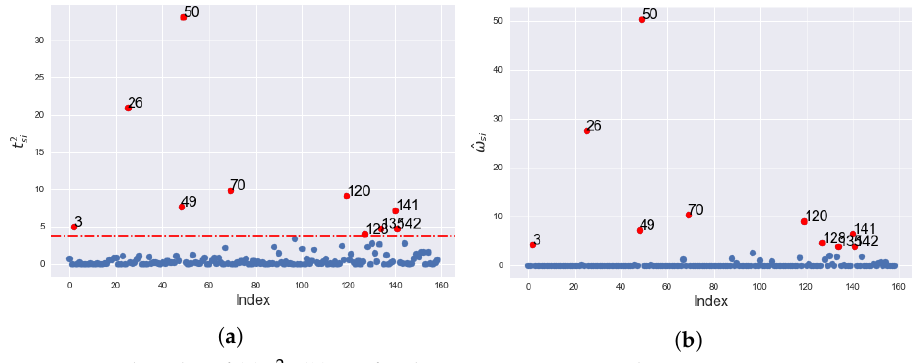
Figure 9. Index plot of ( a ) t 2